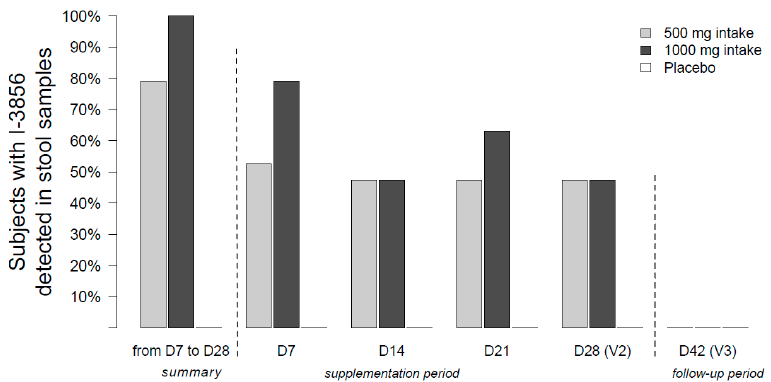
Figure 4. Proportion of women (%) with S. cerevisiae CNCM I-3856 detected in stool samples at each study timepoints ( n = 19 for Probiotic 500 mg group, n = 19 for 1000 mg group and n = 19 for placebo group).